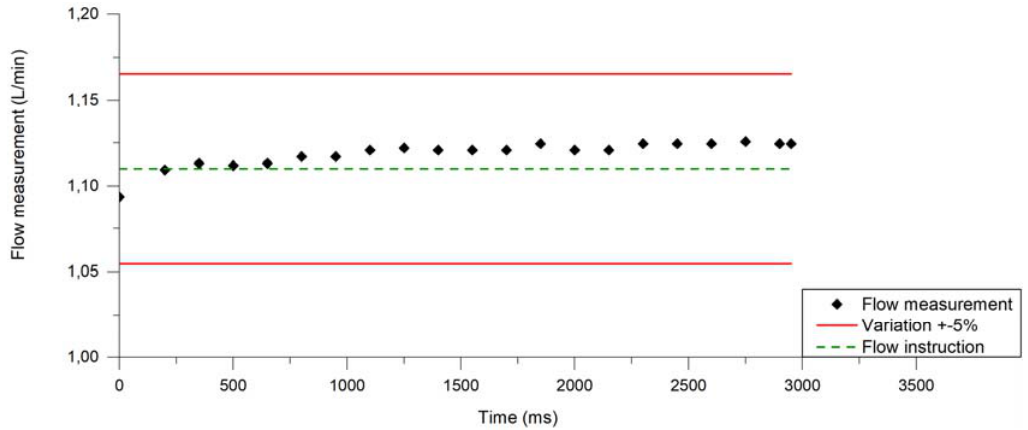
Figure 2. Flow profile puffs generated on U-SAV (dark dots) at 1.11 L/min airflow rate. Red lines represent ±5%.